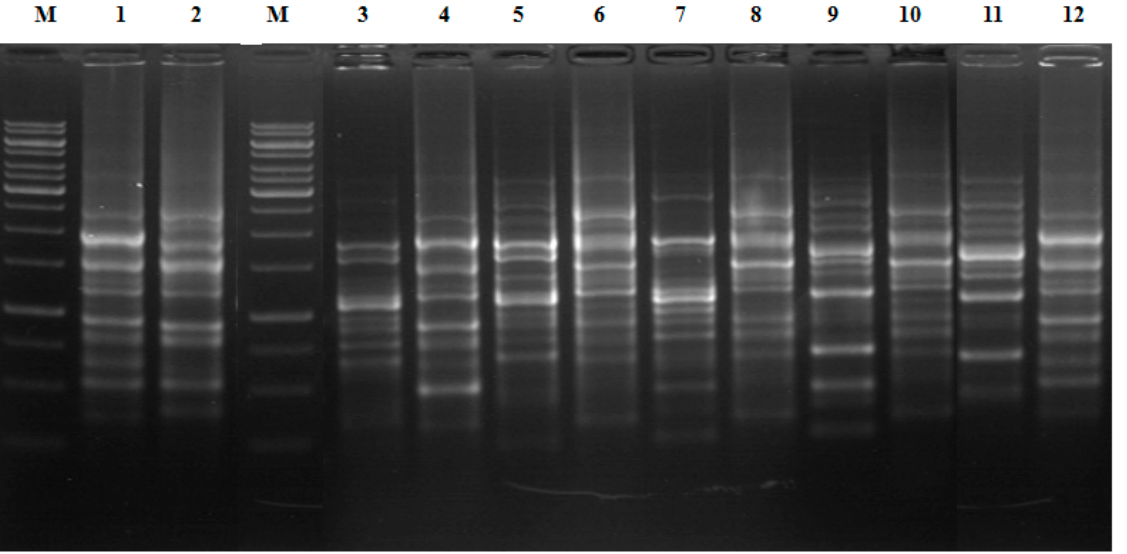
Figure 1. REP-PCR pa tt erns of the isolates. Lanes: 1, G4-2; 2, O18; 3, H4a; 4, H4b; 5, J11a; 6, J11b; 7, J12a; 8, J12b; 9, L9a; 10, L9b; 11, O4a; 12, O4b; M, 1 kb DNA size